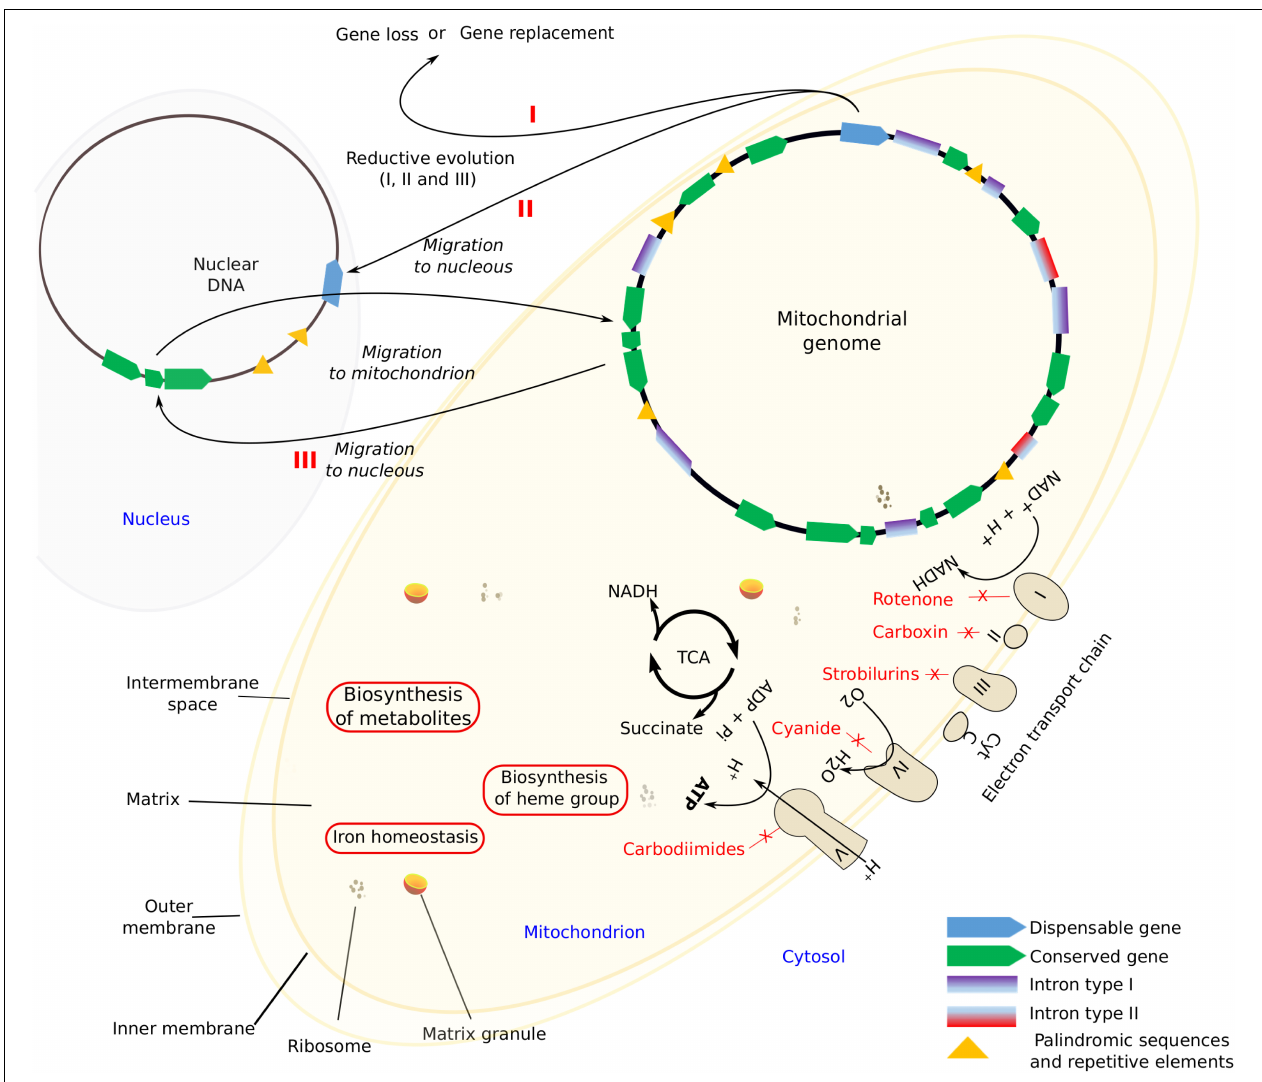
FIGURE 1 | Mitochondrial components and the main features. I, II, and III (in red) schematic processes that lead to the size reduction of mitochondrial genome by gene